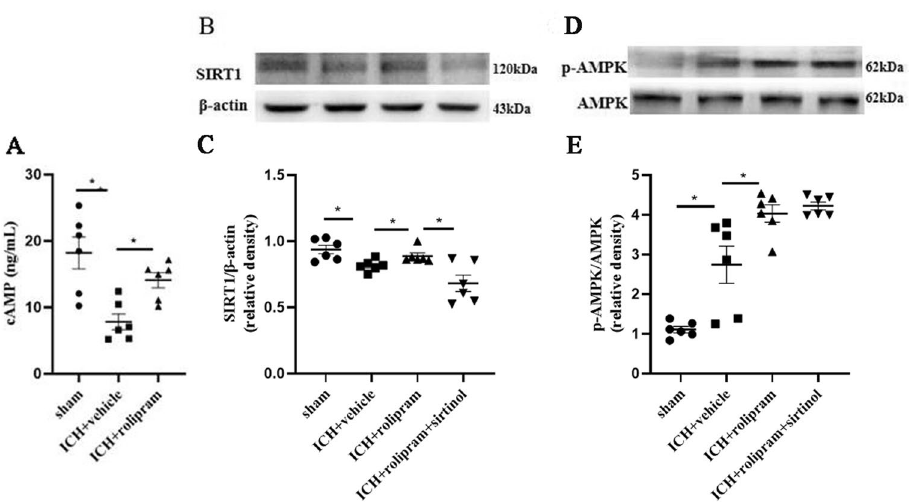
Figure 6. Rolipram activated the cAMP/AMPK/SIRT1 pathway after ICH. ( A ) The level of cAMP in the different groups. ( B – E ) Representative images and the quantification of western blot results showing SIRT1, p-AMPK and AMPK expression on day 3 after ICH. The Mann–Whitney U test was used to compare differences between groups in western blot. The data are presented as the means ± SEM. * p < 0.05 (Supplementary Information